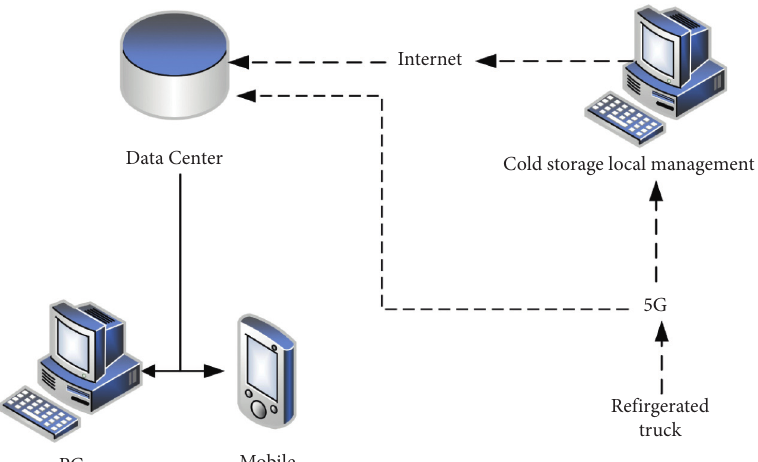
Figure 2: System data flow diagram.